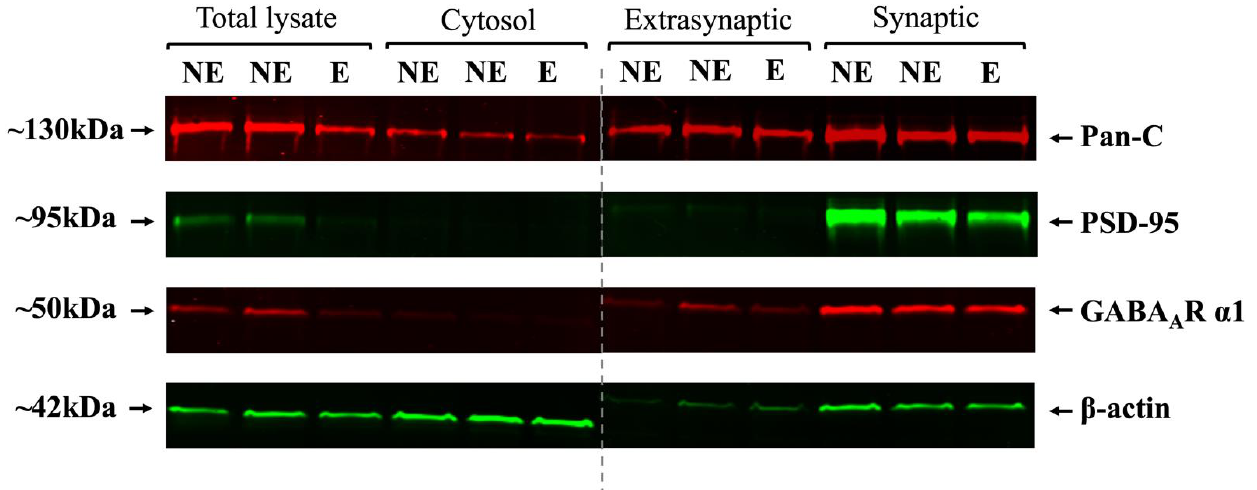
Figure 6. Pilot WB run for biochemically isolated primary SoCx subcellular fractions (total lysate, cytosol, extra-synaptic and synaptic). This run confirmed the successful isolation of the synaptic fractions given the intense labelling for both PSD95 and GABA A R α1. Extra -synaptic fraction, on the other hand, showed no bands for PSD95, but low intensity bands were seen for GABA A R α1 and β - actin. PanC showed good expression in all subcellular fractions.